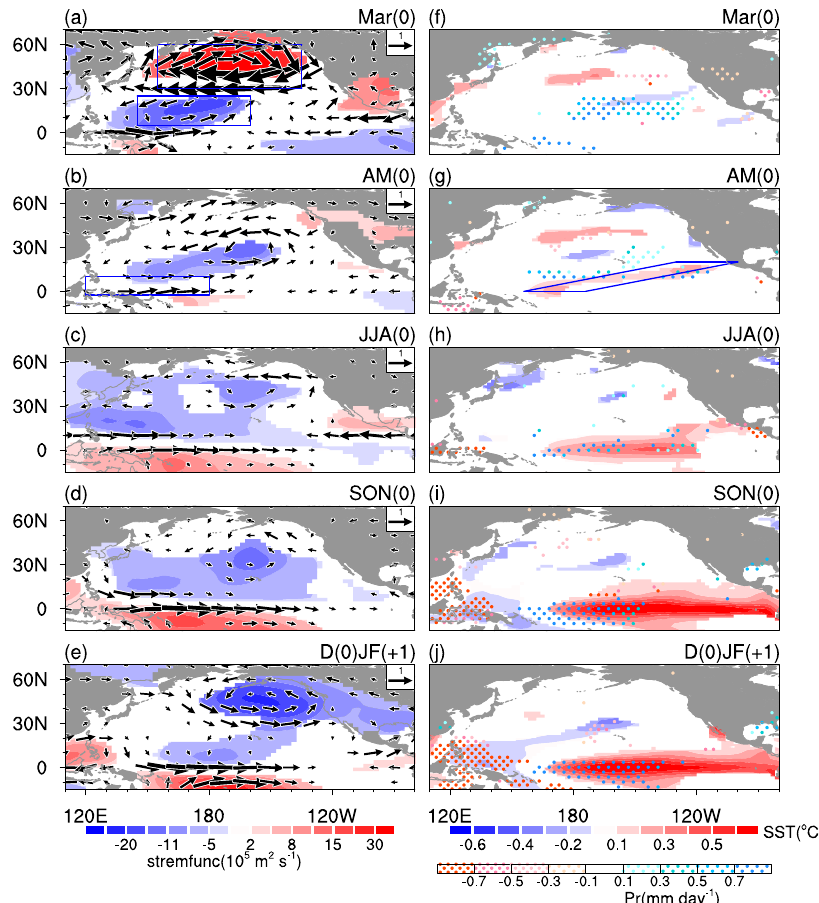
Fig. 2 Evolutions of SST and atmospheric anomalies related to the early spring ALI. Anomalies of 850-hPa stream function (shading) and winds (vector) in a Mar(0), b AM(0), c JJA(0), d SON(0), and e D(0)JF(1) regressed upon the normalized ALI in Mar(0) over 1996 – 2018. f – j as in a – e , but for the evolutions of SST (shading) and precipitation (stippling) anomalies. Only the SST, precipitation and stream function anomalies exceeding the 95% con fi dence level are